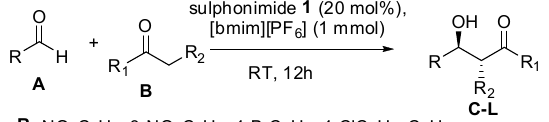
Table 3. Aldol reactions using different aldehyde and ketone. Table 4. Recyclability test for sulphonimide 1 [bmim][PF